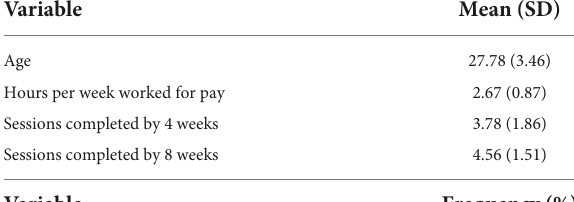
TABLE 1 Demographics and Listening Visits session